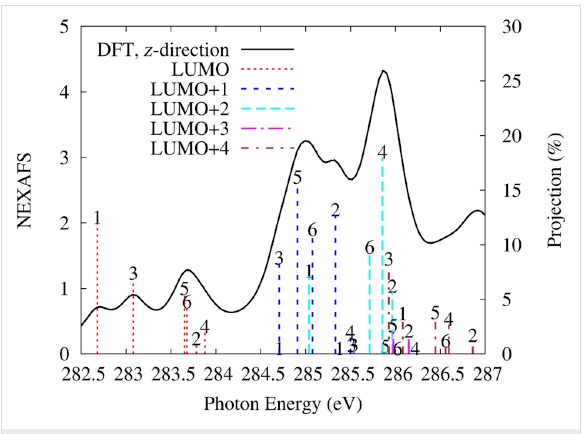
Figure 6: Simulated NEXAFS of the gas phase V-shaped pentacene from the B-site along the z -direction of the field, perpendicular to the molecular plane. For excitations from each C atom, the vertical bars numbered correspondingly show the projection of the various molecu- lar orbitals, computed with a half core hole in that atom, on the 2p z state of the same carbon atom, and are referred to the axis on the right (in